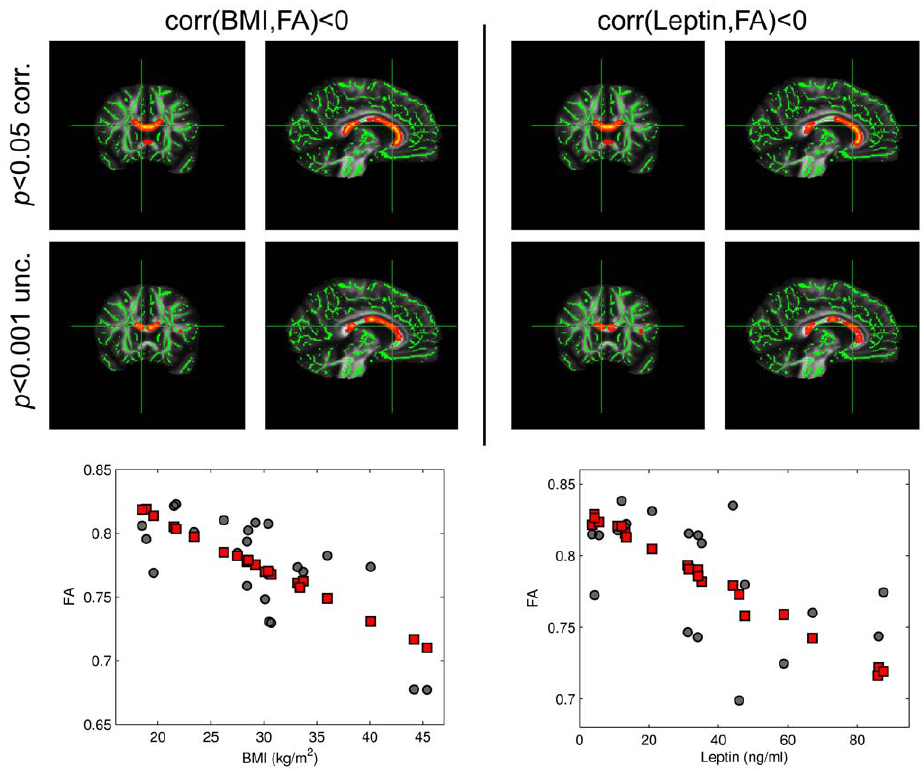
Figure 2. Coronal and sagittal brain slices showing a negative correlation (color-coded in red/yellow) between FA and body weight using BMI (left) and leptin levels (right) in women. The result was obtained using the ‘randomise’ tool of FSL ( p , 0.05, corrected; top row), and the statistics in SPM8 ( p , 0.001, uncorrected; bottom row). The dot plots (see bottom of the figure) show the FA values of the women in a selected voxel (green cross-hair in the brain slices). Black dots and red squares show original and age-corrected FA values, respectively.